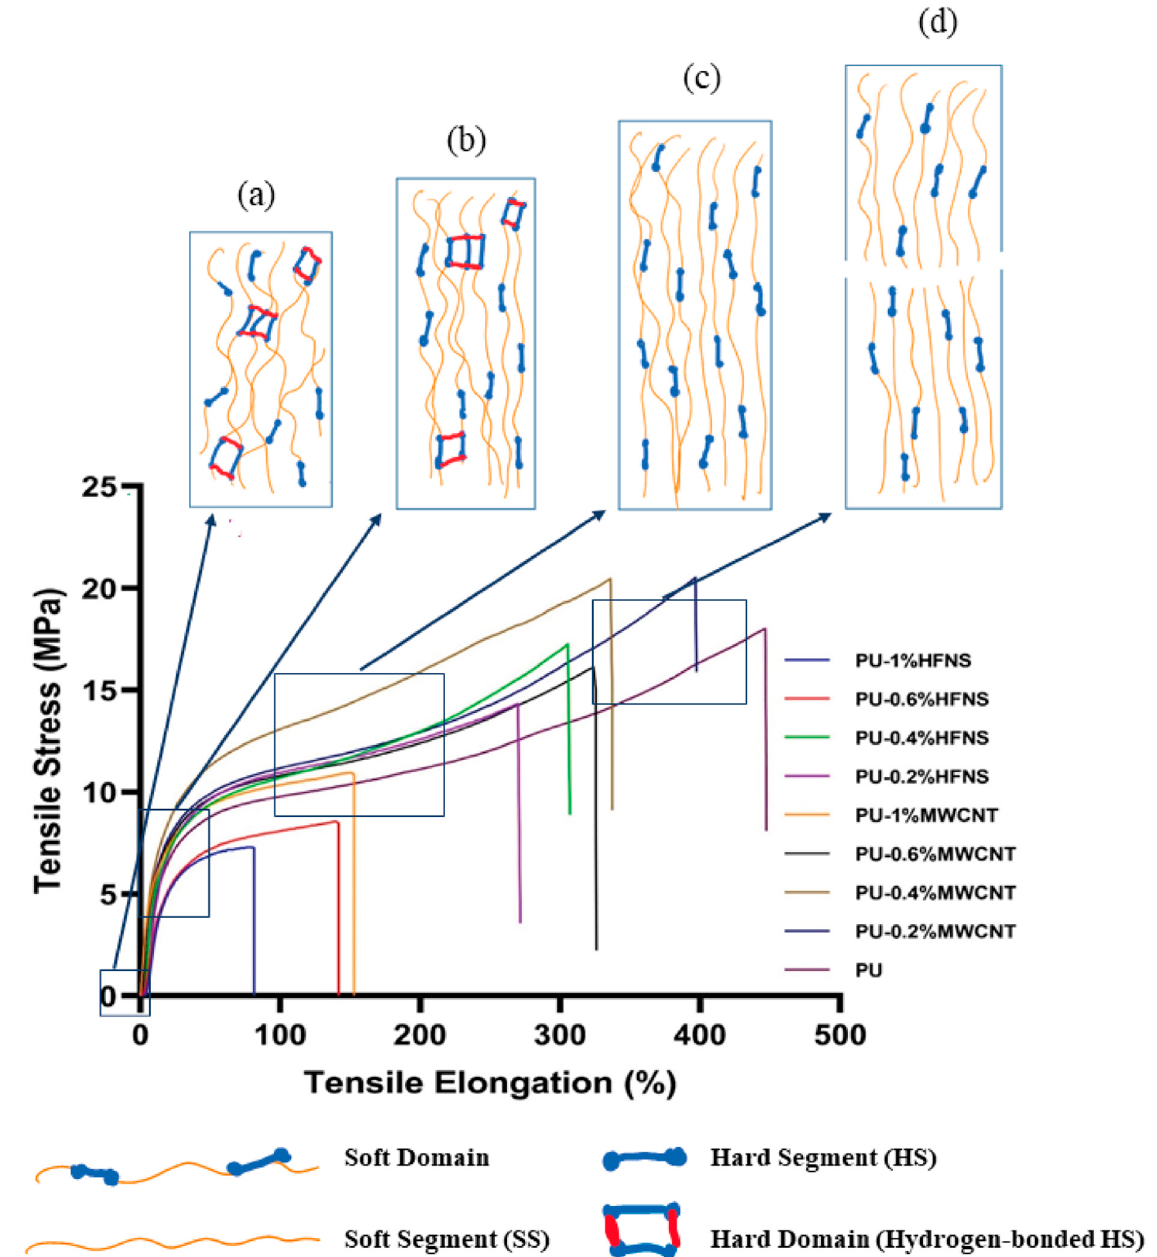
Figure 5. Engineering stress–strain of samples demonstrating highest tensile strength of polyurea and polyurea nanocom- posite ( a ) chain arrangements at 0%, ( b ) chain motions during elastic deformation, ( c ) breakage of hard domain during plastic deformation and ( d ) fracture of polyurea chains.